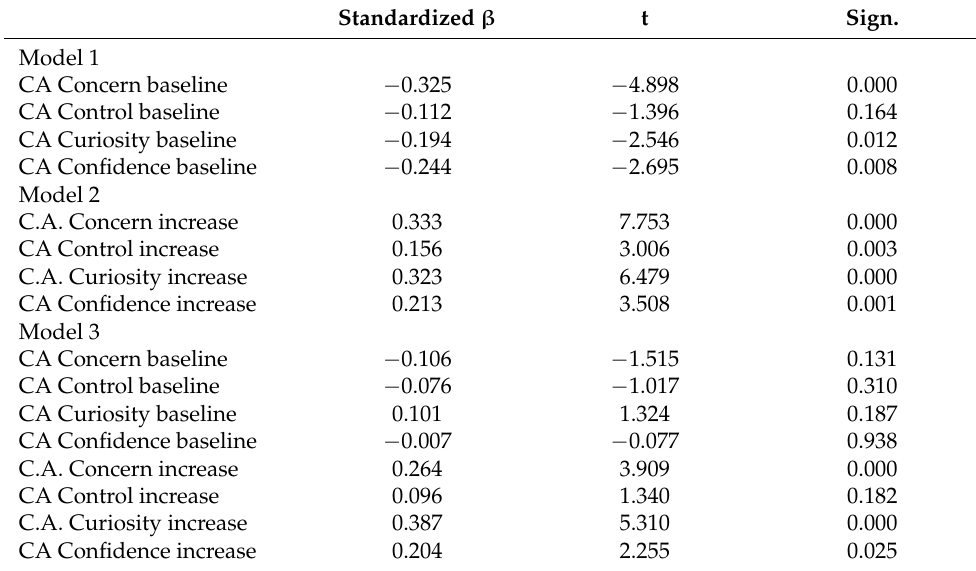
Table 5. Role of career adaptability baseline and increase in explaining